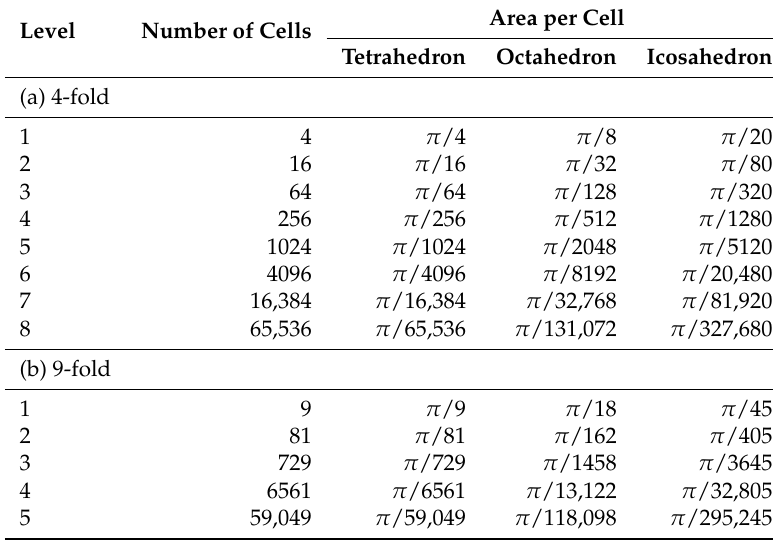
Table 2. Cell counts and standardized surface areas for DGGSs based on a single face of the spherical tetrahedron, octahedron, and